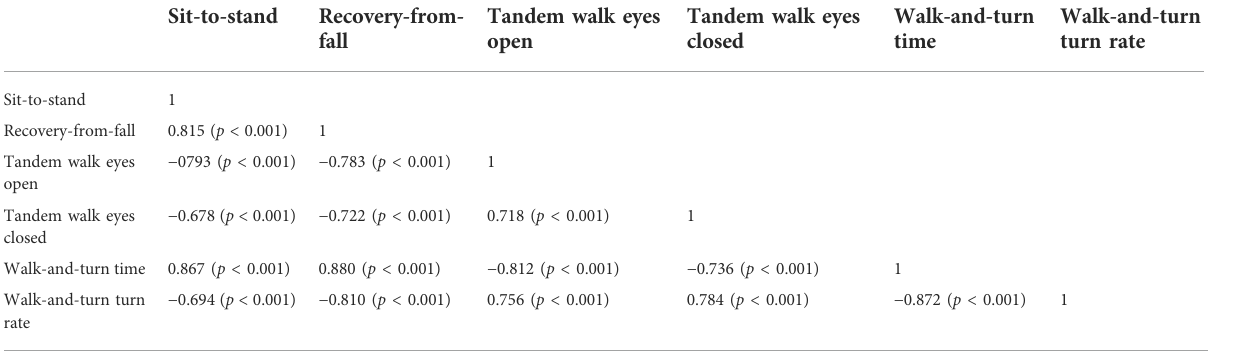
Tandem walk eyes open